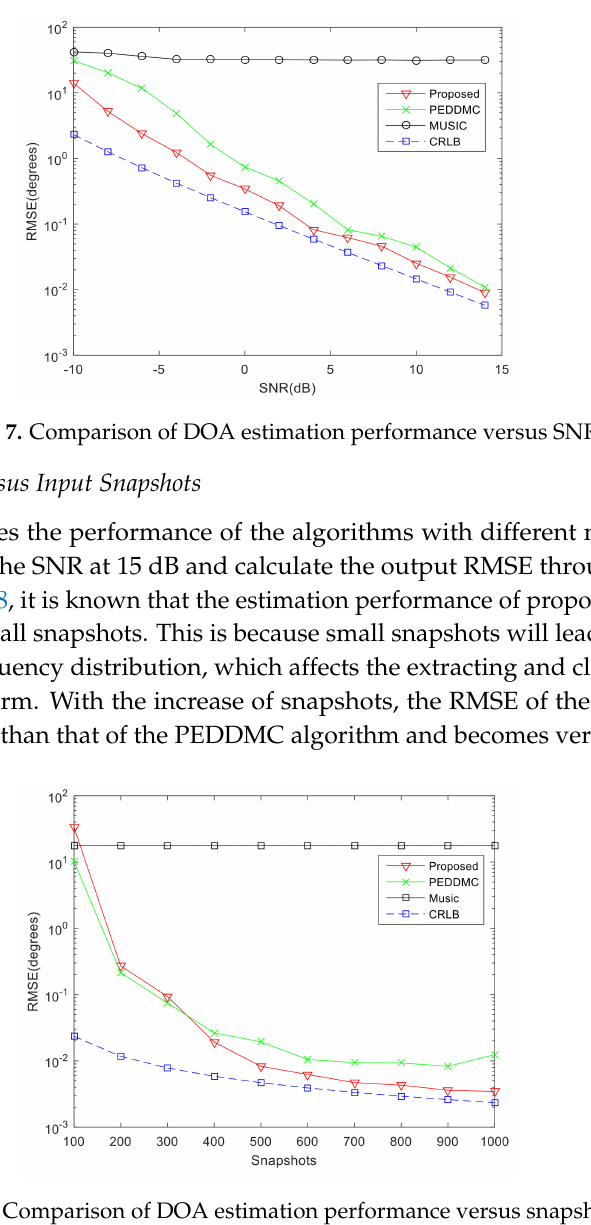
Figure 8. Comparison of DOA estimation performance versus